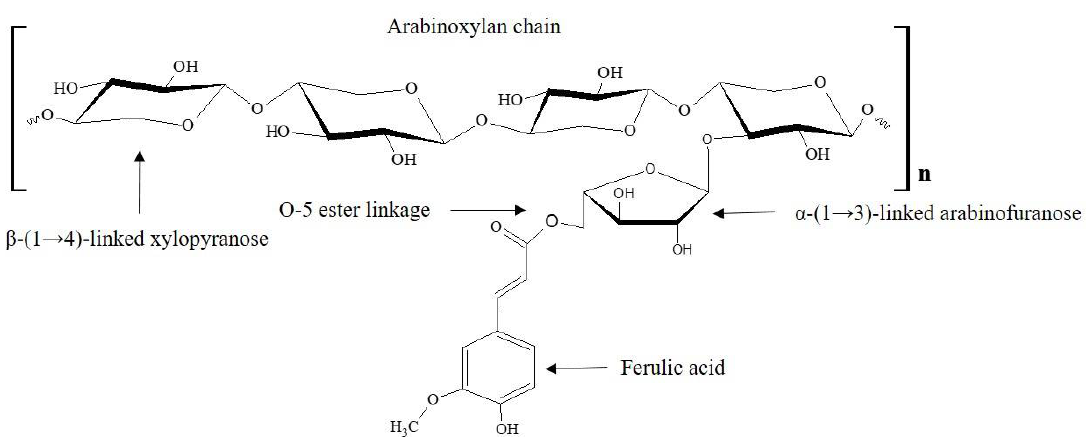
Figure 1. Chemical structure of maize ferulated